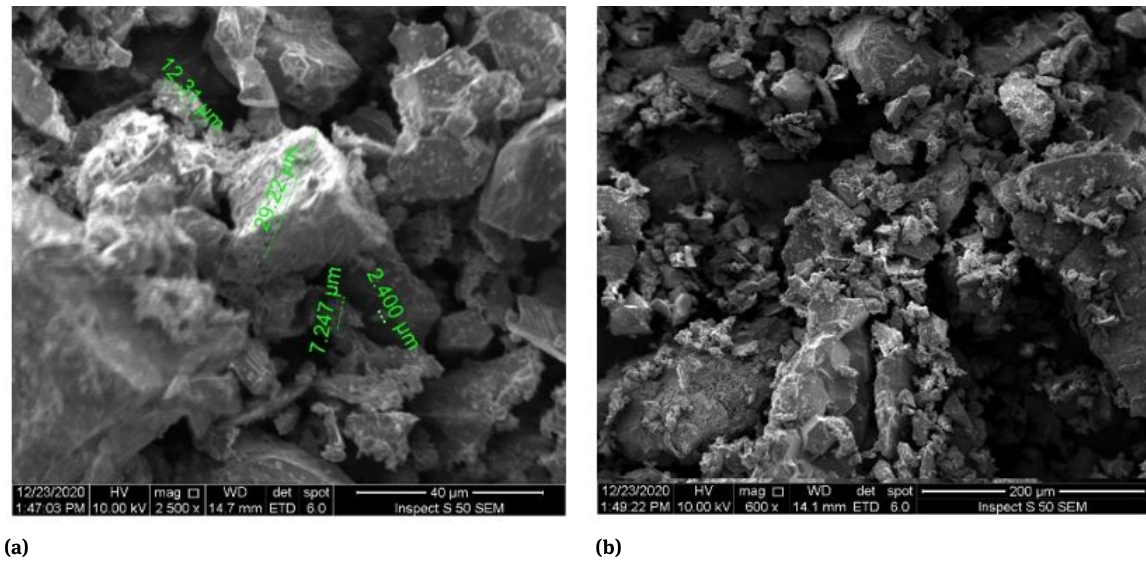
Figure 4: Multilayered of sample no:2 from forging material steel AISI 1045 a) 40 µ m b) 200 µ